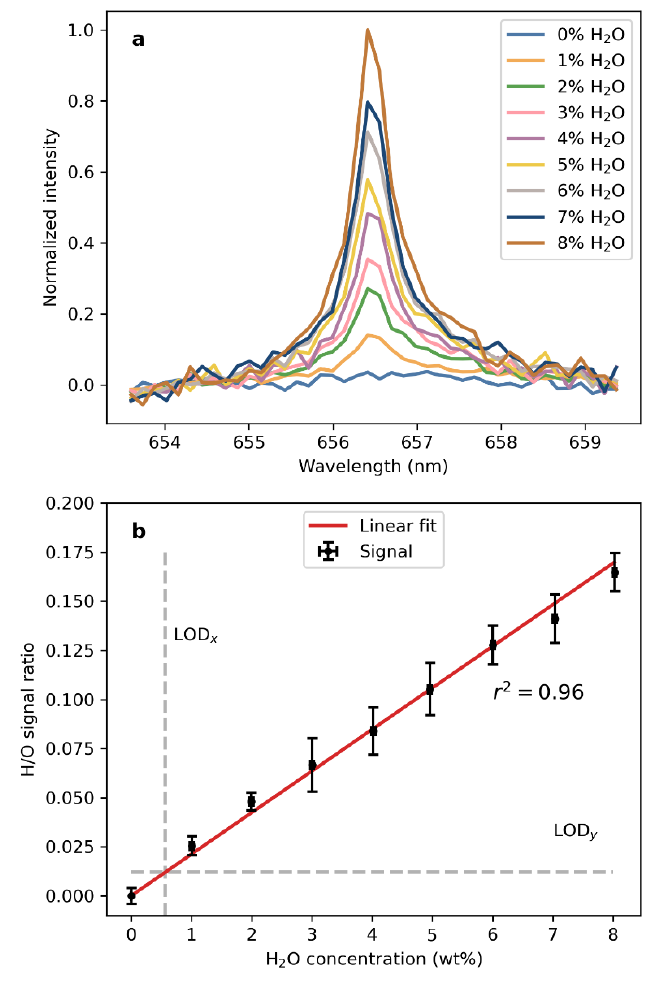
Figure 7. ( a ) H(I) line at 656.46 nm in the LIBS spectra of the samples mixed from CaSO 4 · 2H 2 O and Na 2 SO 4 , normalized by the O(I) triplet at 777.5 nm. ( b ) Intensity of the normalized H(I) line independent of the H 2 O concentration in the sample.